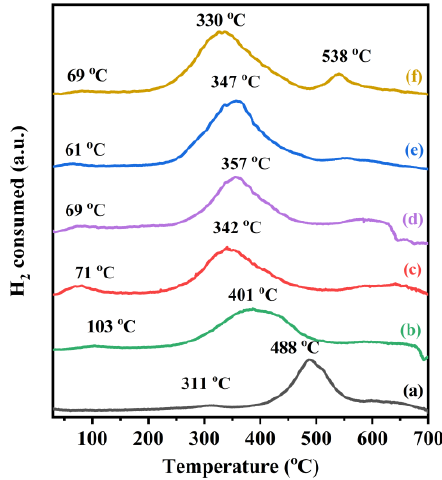
Figure 4. H 2 -TPR profiles of ( a ) TiO 2 , ( b ) 0.36Au/TiO 2 , ( c ) 0.33Pd/TiO 2 , ( d ) 0.35AuPd 0.46 /TiO 2 , ( e ) 0.34AuPd 2.09 /TiO 2 , and ( f ) 0.37AuPd 2.72 /TiO 2 . Table 2. Catalytic activities at SV = 40,000 mL/(g h), apparent activation energies ( E a ), metal dispersion, TOF Pd , TOF Noble metal , specific reaction rates at 220 °C, and H 2 consumption of the samples.